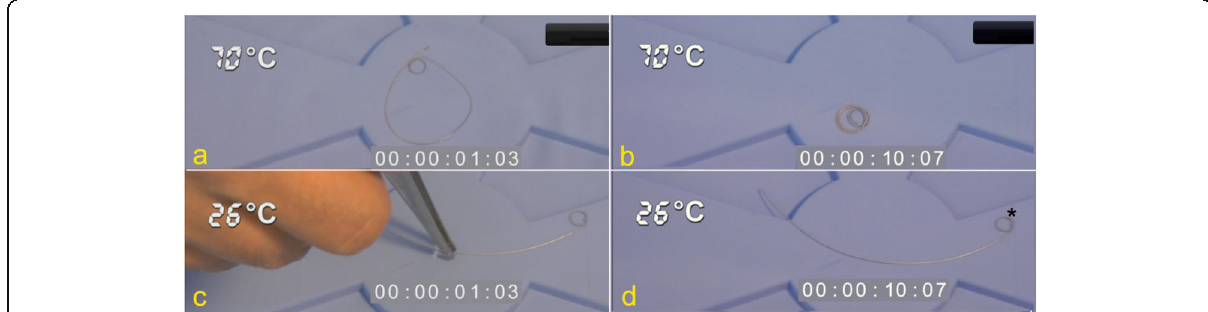
Fig. 3 HydroCoil configuration changes according to different water temperatures. a shows a first loop configuration (Configuration II) after only 01:03 s in a 70 °C water immersion. b shows complete coiling (Configuration III) after only 10:07 s in a 70 °C water immersion. c shows a HydroCoil during the first second after immersion at 26 °C; only a discrete strain (Configuration I) was observed after 10:07 s in a 26 °C water bath immersion ( d ); this HydroCoil remained without configurational changes even after several minutes (not shown). NOTE: All HydroCoils are designed with a preformed first loop at the tip of the filament (black asterisk); in normal conditions, this first loop facilitates the initial binding of the HydroCoil. This first loop should not be misinterpreted as a temperature-induced coil binding, which actually comprises the totality of the HydroCoil